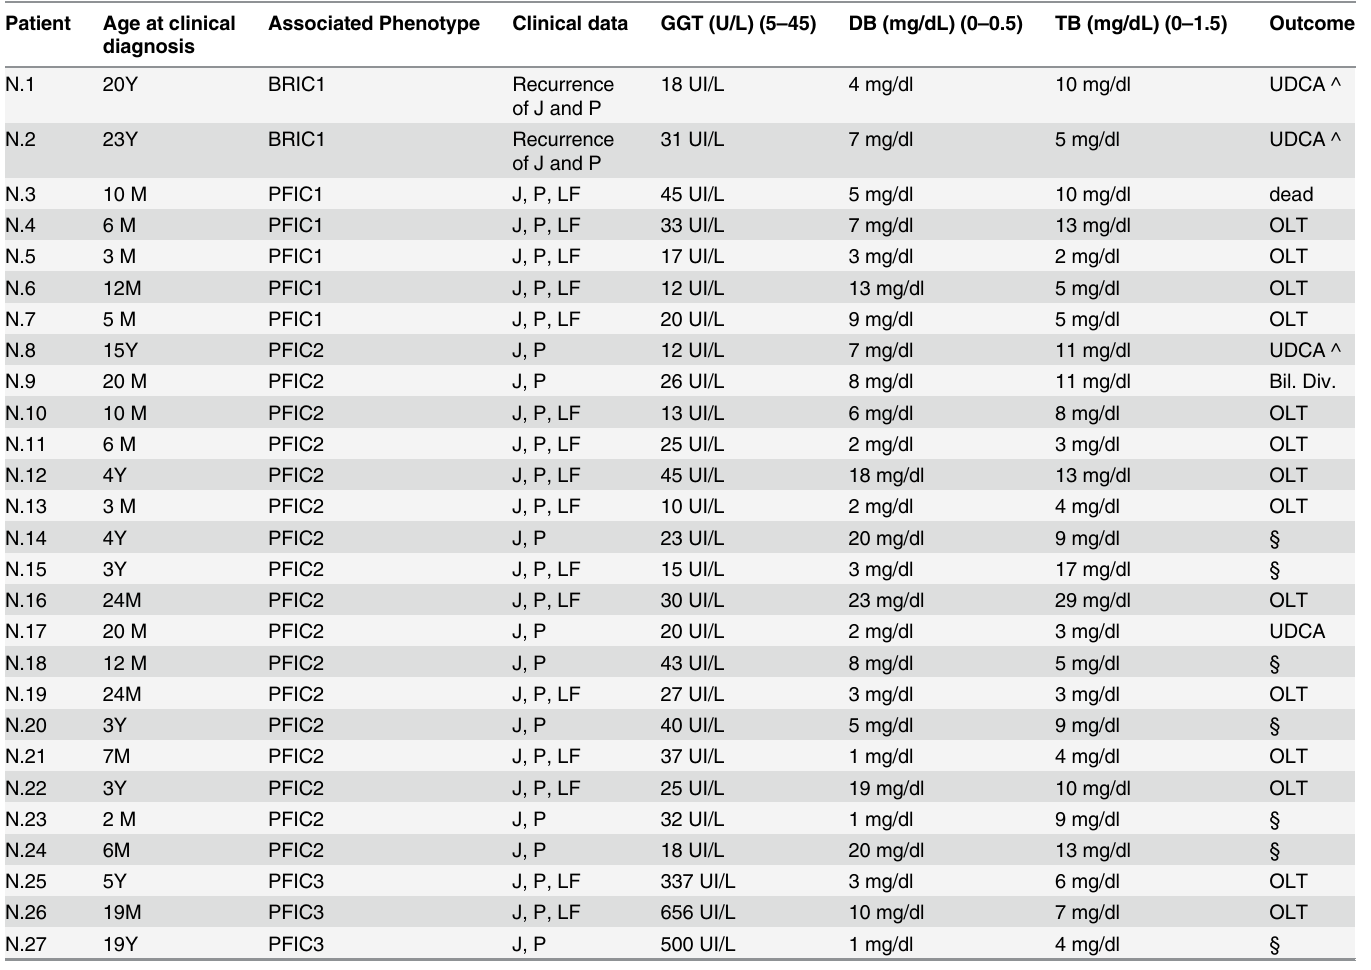
Table 1. Patients